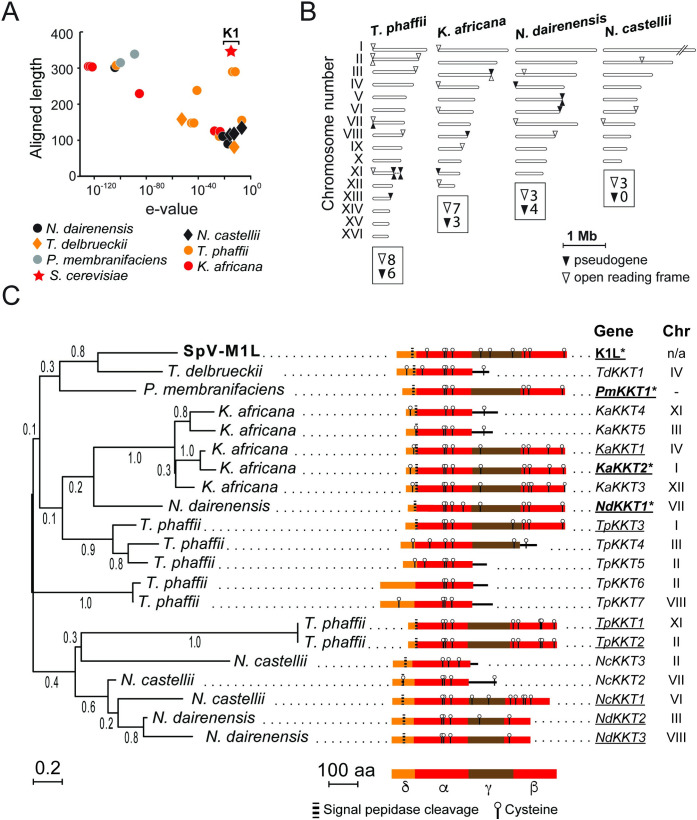
KKT genes are distributed across the subphylum Saccharomycotina and are primarily subtelomeric in their genomic location.(A) PSI-BLAST analysis of the killer toxin encoded upon the satellite dsRNA from S. paradoxus Y-63717. (B) Location of KKT genes and pseudogenes on the linear representation of the chromosomes of four yeasts of the Saccharomycetaceae. Chromosome I of N. castellii did not contain any KKT genes and was truncated in the diagram due to its large size. (C) Unrooted maximum likelihood phylogeny of the aligned α-domain of 21 killer toxins from six species of yeast and one dsRNA satellite. Numerical values represent the bootstrap support for the placement of each node. The domain organization of each protein is illustrated and annotated based on the four-domain structure of K1. Signal peptidase cleavage site predicted by SignalP and TargetP (S3 File). Underlined killer toxin names represent those that were cloned and functionally tested for antifungal activity. *Killer toxins with confirmed antifungal activities.